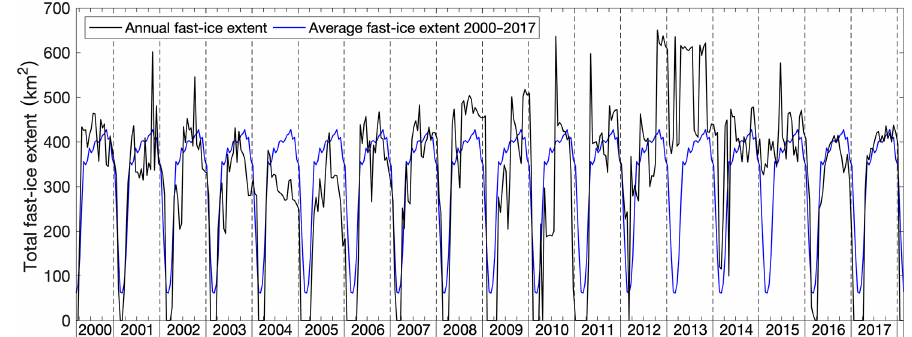
Figure 2. Time series of fast-ice extent in Atka Bay between 8 ◦ 12 (cid:48) and 7 ◦ 24 (cid:48) W derived from MODIS data between early 2000 and early 2018 (black line). The blue line shows the annual mean extent repeated each year over the same time period. The average fast-ice extent over the entire time series is 319 . 2 ± 167 . 8km 2 , with an uncertainty of 86.6km 2